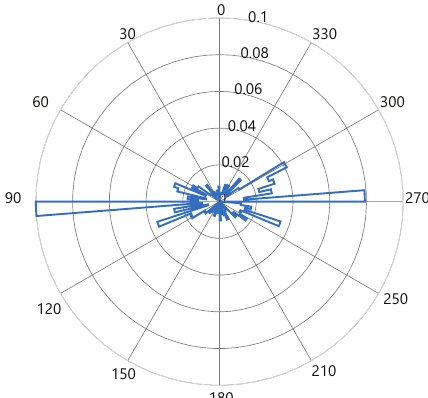
Figure 15. Histogram of the wind direction in the Cala dell’Acqua